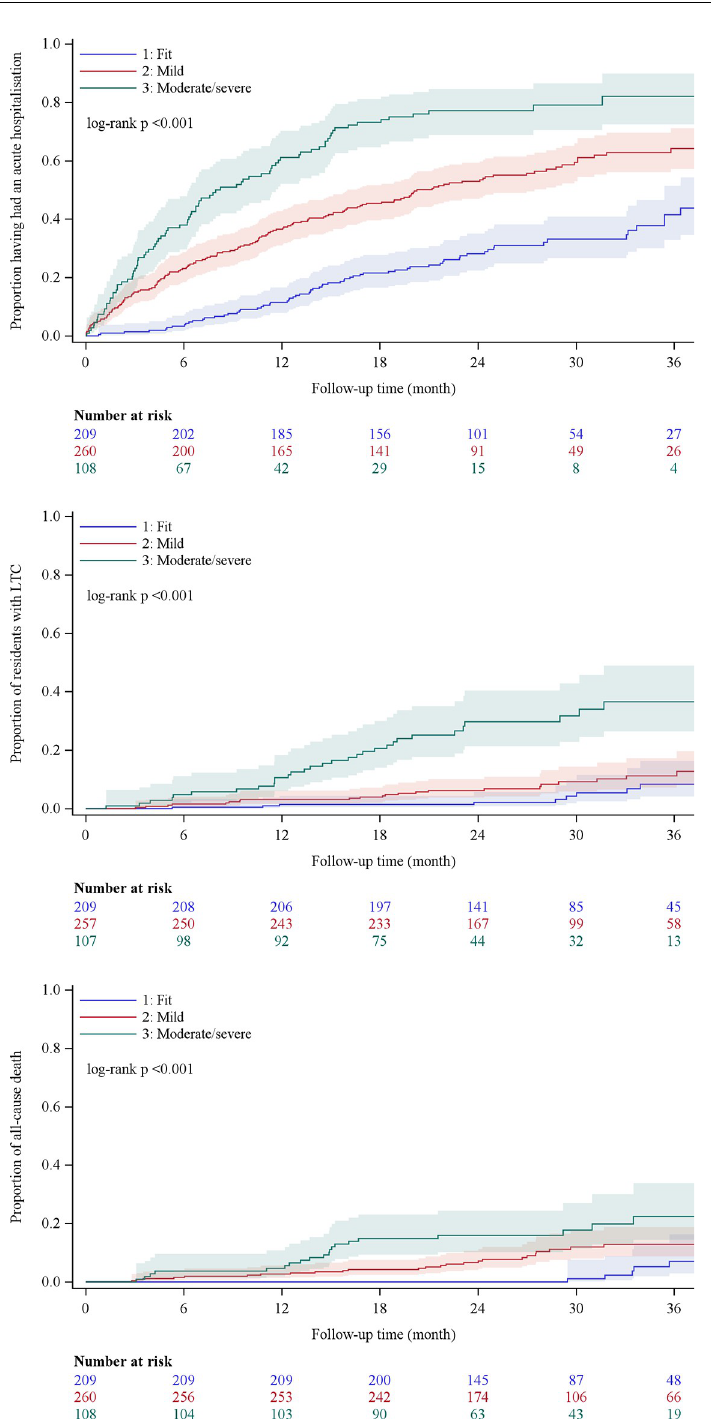
Fig 2. Proportion of residents with a healthcare outcome during follow-up by frailty categories (A) acute hospitalization, (B) LTC, (C) death. Notes, LTC long term care. higher values were used ( � 0.21–0.3 pre-frail, > 0.3 frail) than in our study [29, 31–33]. In those reporting adverse outcomes, higher FI scores were associated with hospitalization, mor- tality and LTC [27, 28, 31] with Hogan et al. reporting risk ratios (RR) for hospitalizations of